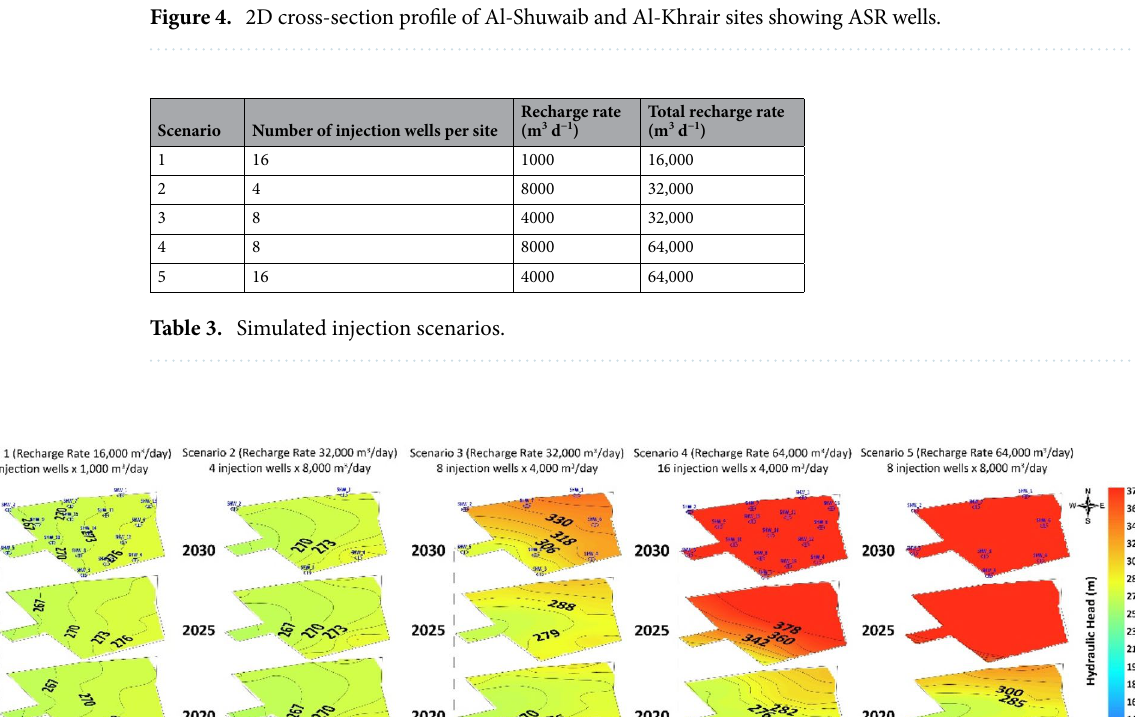
Figure 4. 2D cross-section profile of Al-Shuwaib and Al-Khrair sites showing ASR wells.